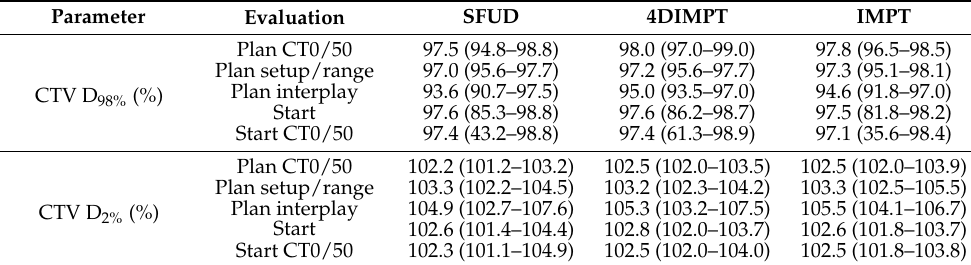
Table A4. Robust evaluation of CTV dose, showing median values and range.